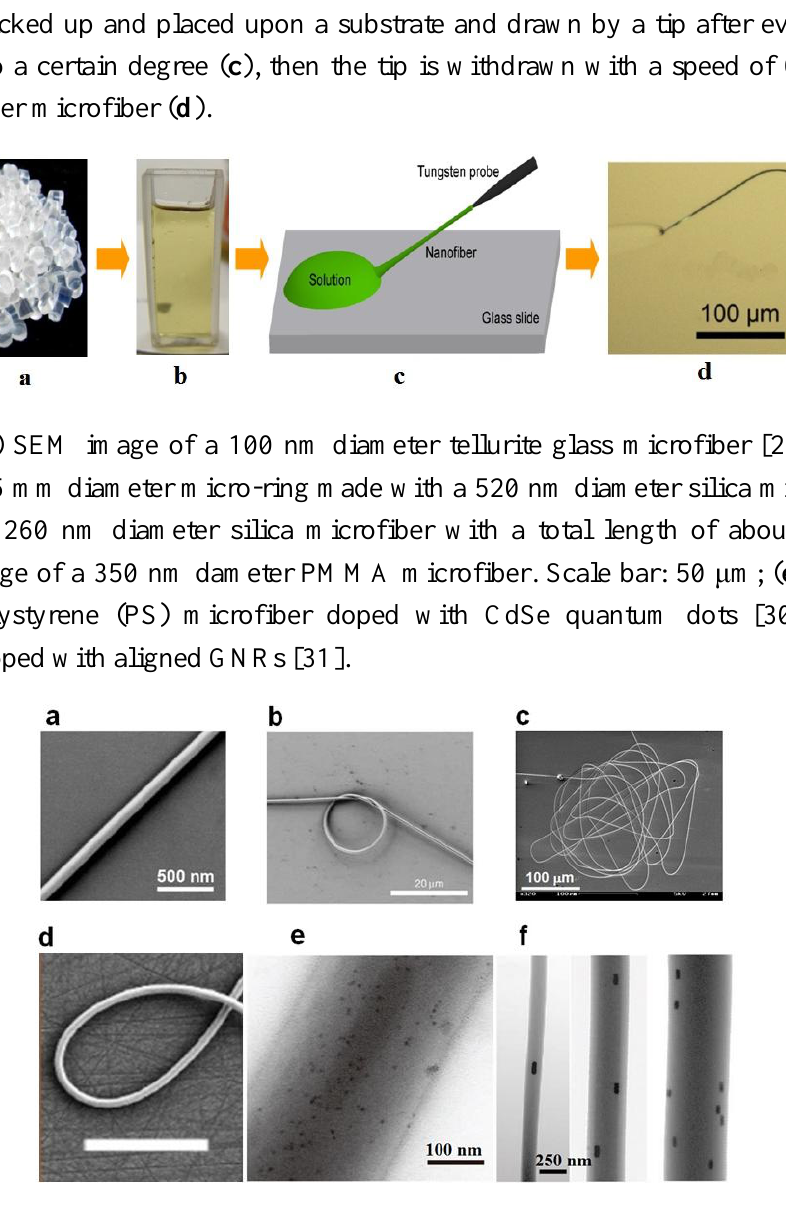
Figure 6. Illustration of direct drawing a polymer microfiber from a solution. Bulk